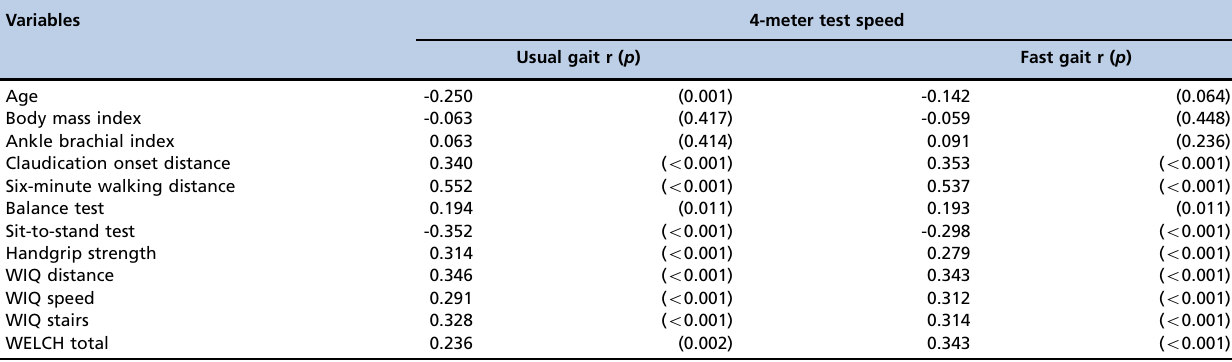
Table 2 - Correlations between 4-meter test speed with objective and subjective measurements of physical function in symptomatic peripheral artery disease patients (n=169). Variables